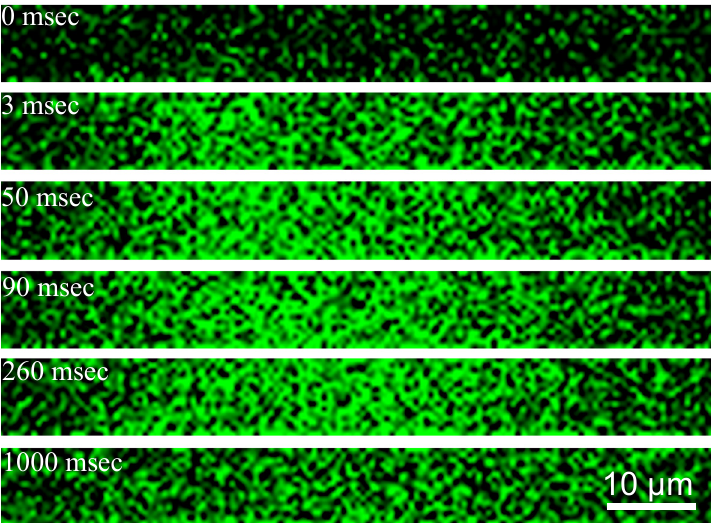
Figure 14. Fluorescence images of release of calcein dye from a suspension of gold-coated liposomes following a single 50 µm diameter light pulse. Prior to irradiation, the calcein fluorescence is quenched in the liposomes. Three microseconds after irradiation, the fluorescence intensity increases and reaches a maximum at ninety seconds. The fluorescence gradually decreases due to dilution. Adapted from [47], published by Wiley, 2020.